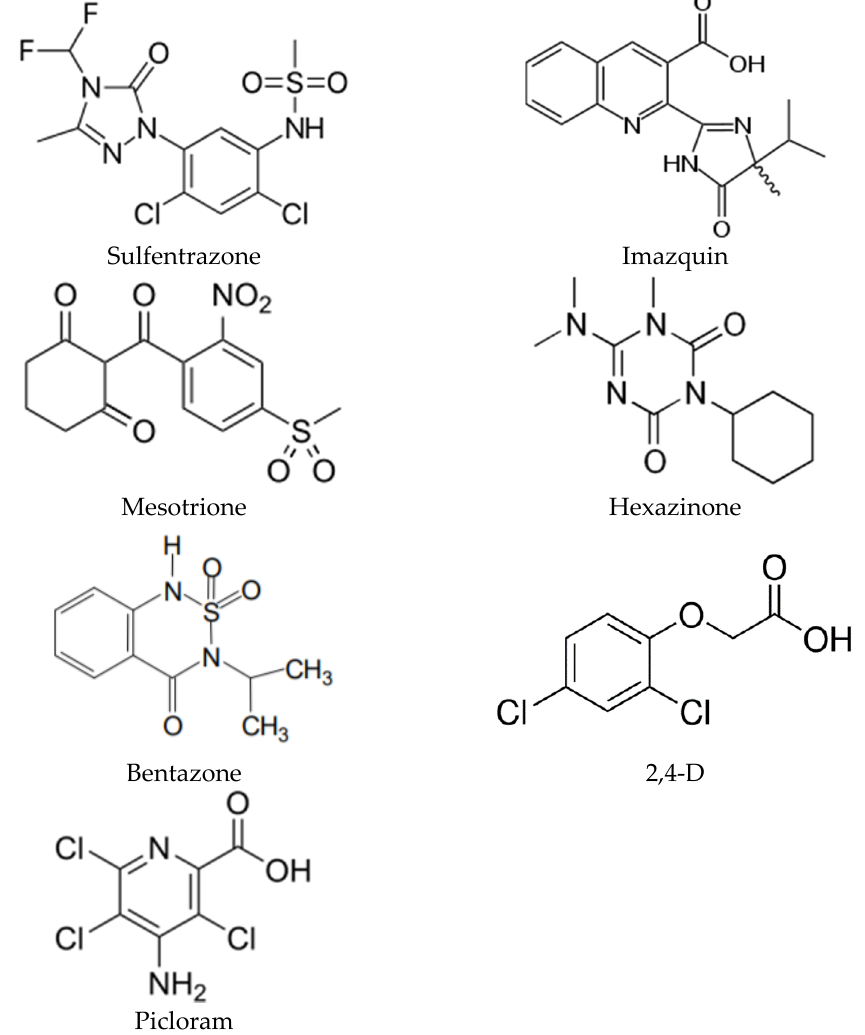
Figure 2. Surfactants and Herbicides.